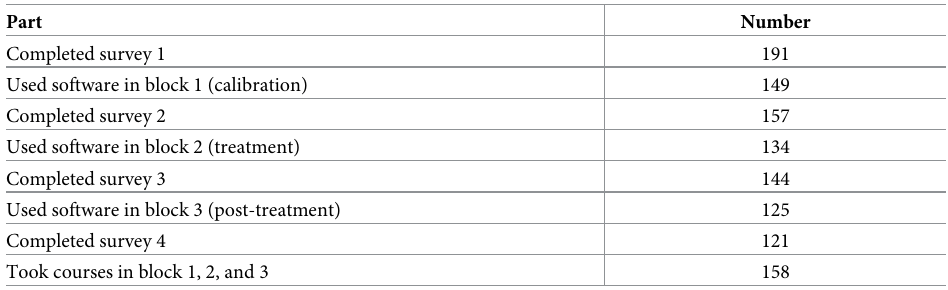
Table 2. Number of